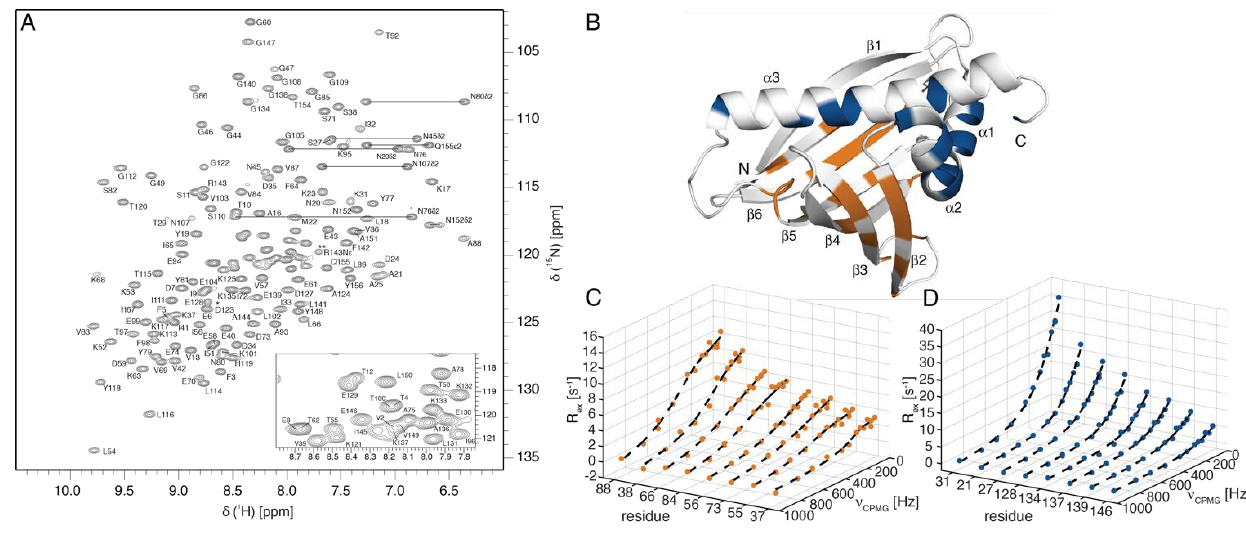
Figure 4. Backbone amide NMR resonance assignments and relaxation-dispersion data for Ara h 8.0101. ( A ) The 700 MHz 1 H – 15 N – HSQC spectrum of Ara h 8.0101 (0.5 mM) in 20 mM sodium phosphate (pH: 6.9), supplemented with 10% D 2 O, at 25 ◦ C. Assignments are shown using single–letter codes. Horizontal lines indicate asparagine and glutamine NH 2 side–chain resonances. The resonance labeled by one asterisk indicates a residue below the intensity cutoff, the signal labeled by two asterisks indicates the aliased signal of the single arginine sidechain ε –NH. ( B ) Structure of Ara h 8.0101 (PDB: 4MA6) with backbone amides that were used in global fits of the 15 N relaxation-dispersion data in the β -sheet and three α -helices, highlighted in orange and blue, respectively. ( C , D ) Backbone amide 15 N relaxation-dispersion data for eight representative amino acid residues in the β -sheet ( C ) and in helices α 1 –α 3 ( D ). Exchange contributions (R ex ), which are calculated as R 2,eff – R 2,eff ( ν CPMG = ∞), are shown, along with the best fit-lines, which were obtained separately from the global fits of all the residues in ( C , D ), respectively.